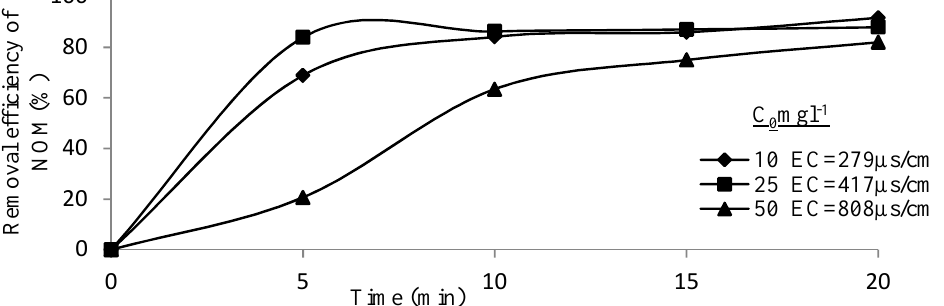
Figure 5. The effect of initial natural organic matter (NOM) concentration on NOM removal efficiencies as a function of reaction time and electrical conductivity (EC) (pH = 7, current = 0.1 A)